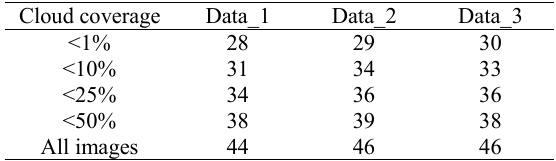
Table 2. The number of images with different degrees of cloud coverage in all subdata sets.